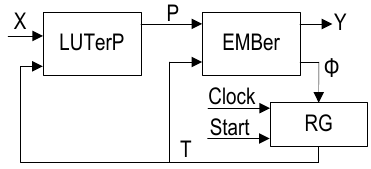
Figure 4. Structural diagram of Mealy FSM U 3